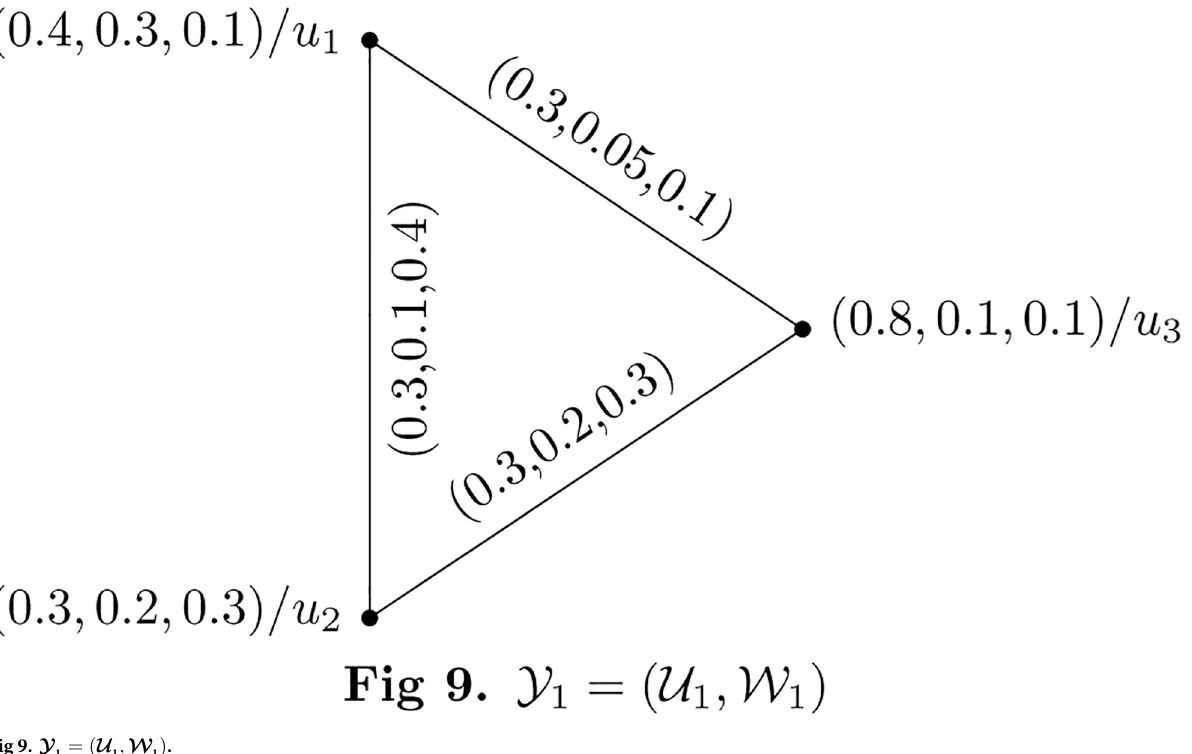
¼ ð U ; W Þ . 1 1 1